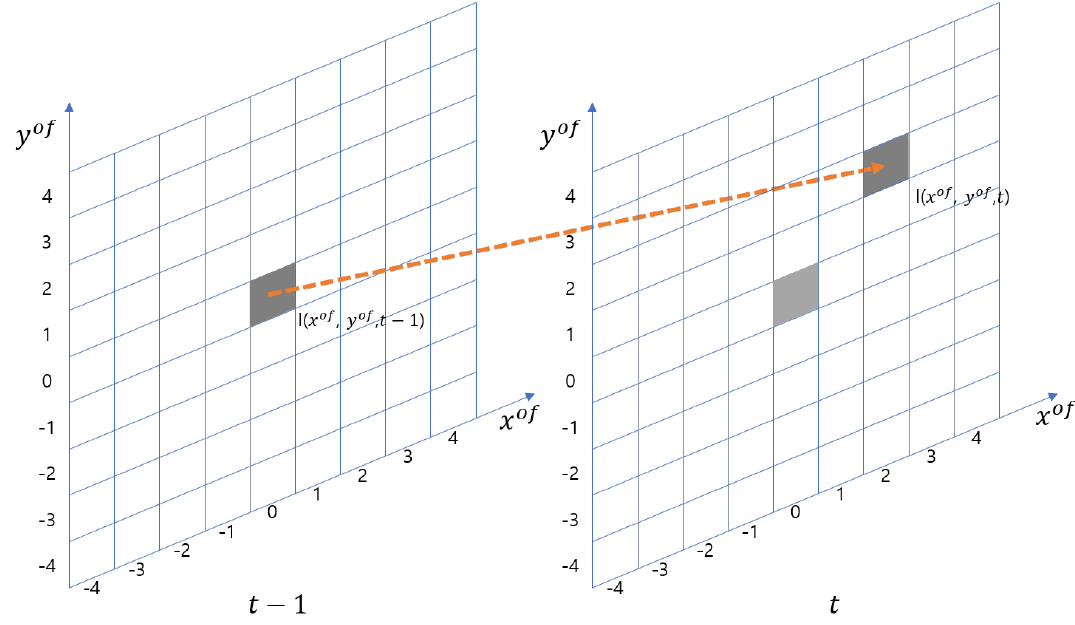
Figure 1. The intensity of a point is the same as time goes from t − 1 to t . For instance, in this figure, I ( 0,0, t − 1 ) = I ( 2,2, t )